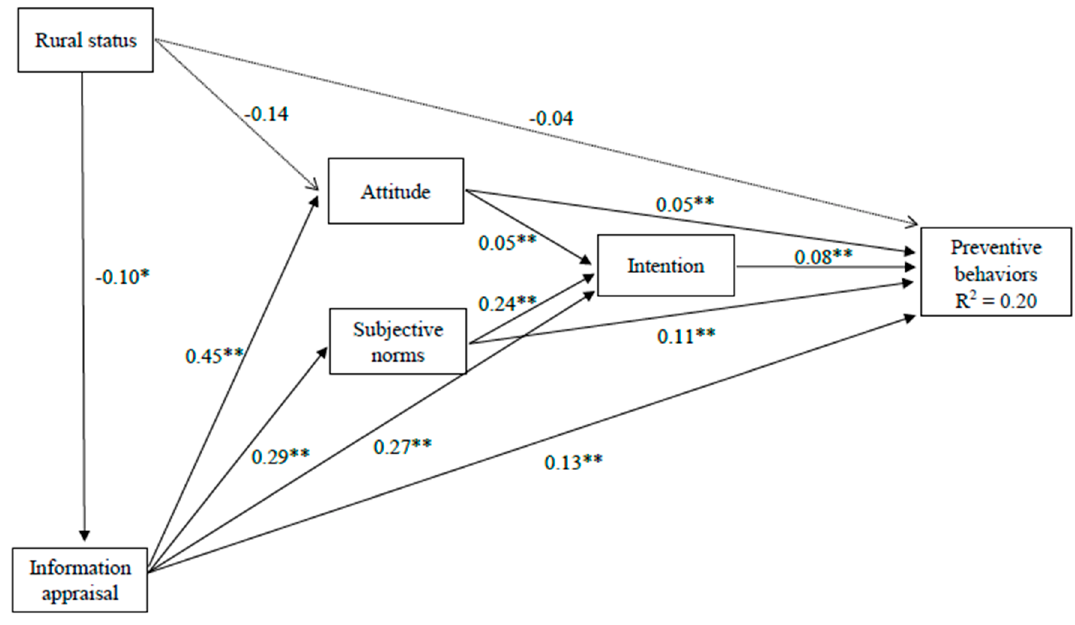
Figure 1. Path model diagram. * p < 0.05, ** p < 0.01.